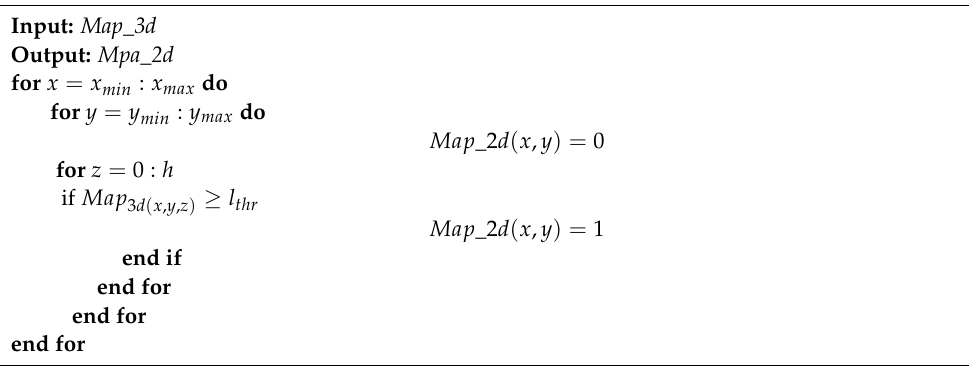
Algorithm 2: Converting the 3D map into a 2D